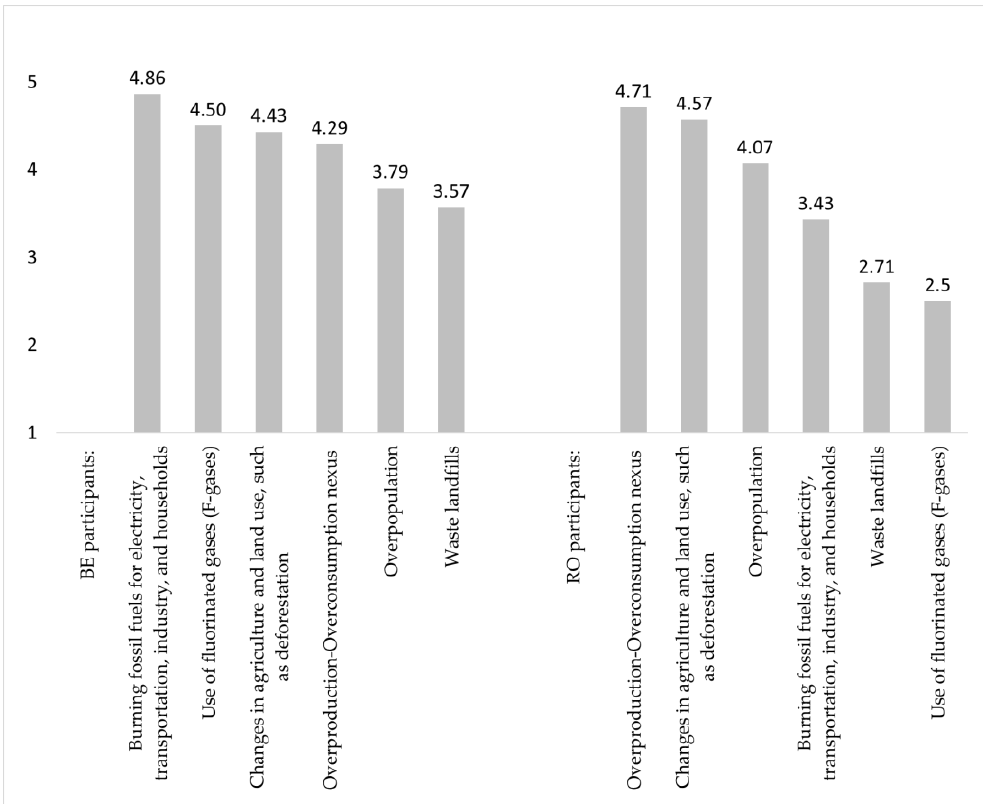
Figure 1. ( a , b ). The matrix of the six science- based climate change topics (the “Quirks”) and their subtopics (generated in Quikos software 2.4.1). ( a ) Romanian participants. ( b ) Belgian participants.